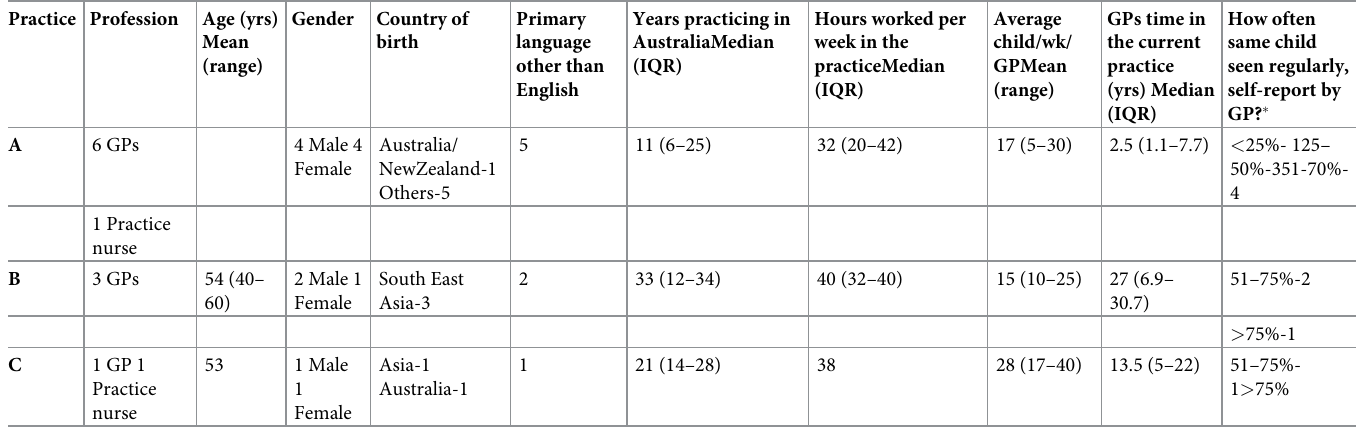
Table 2. Demographic characteristics of the professional